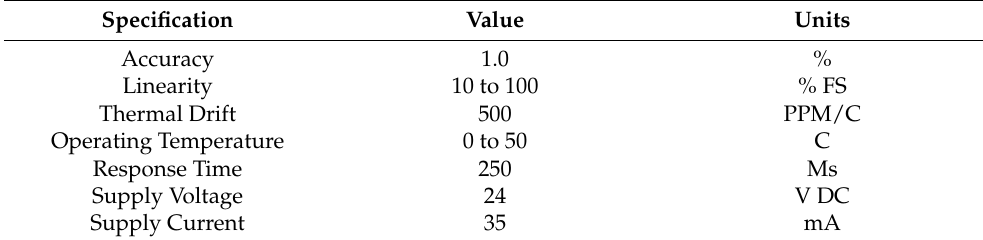
Figure 2. Current and voltage sensor wiring diagram [31,32]. Table 2. Technical Specification of current and voltage sensor [31,32].